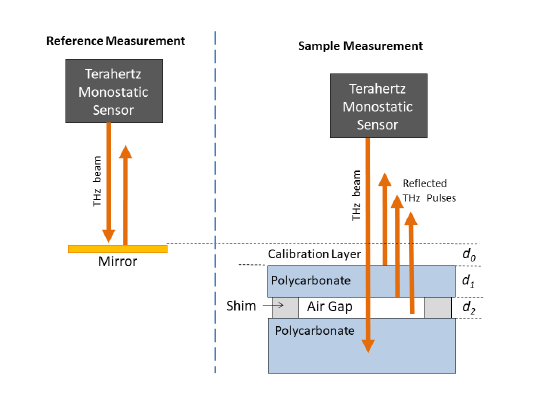
Figure 1. Illustration of the THz NDE experiment configuration (not to scale). ( Left ) Measurement configuration for the THz reference, which is used to approximate the THz source signal in MFP processing. ( Right ) Measurement configuration for the layered sample under test. A calibration layer (air) with unknown thickness, d 0 , accounts for the offset distance between the reference mirror and the surface of the sample. A shim (Scotch R (cid:13) Removable Double Sided Tape) located a distance of d 1 below the sample surface creates an air gap with thickness, d 2 . THz MFP is used to estimate the thicknesses of all three layers ( d 0 , d 1 , and d 2 ),